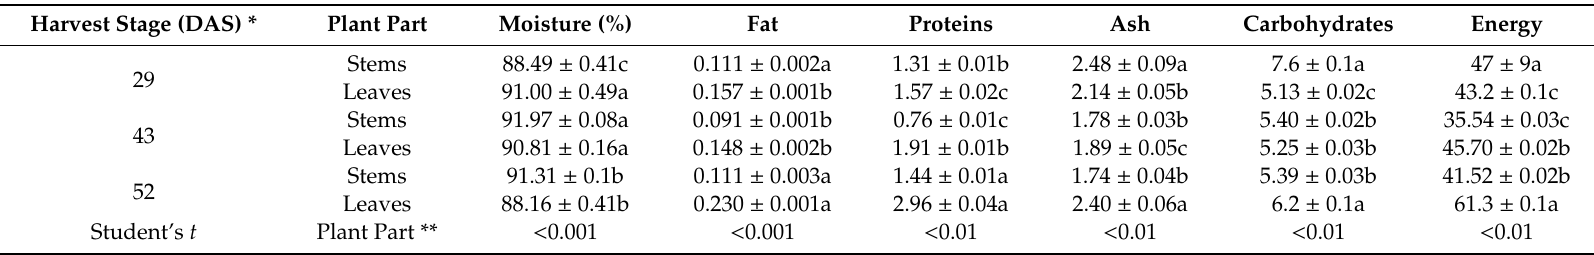
Table 1. Nutritional value (g / 100 g fresh weight (fw)) and energetic value (kcal / 100 g fw) of purslane stems and leaves in relation to harvesting stage (mean ± SD). Harvest Stage (DAS) *